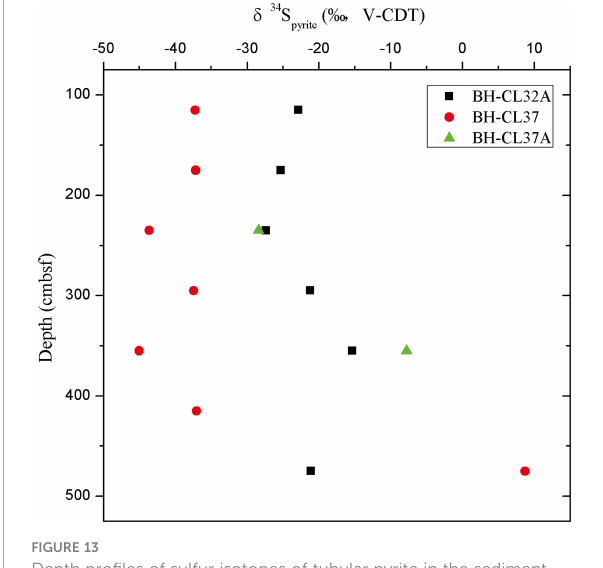
FIGURE 13 Depth pro fi les of sulfur isotopes of tubular pyrite in the sediment